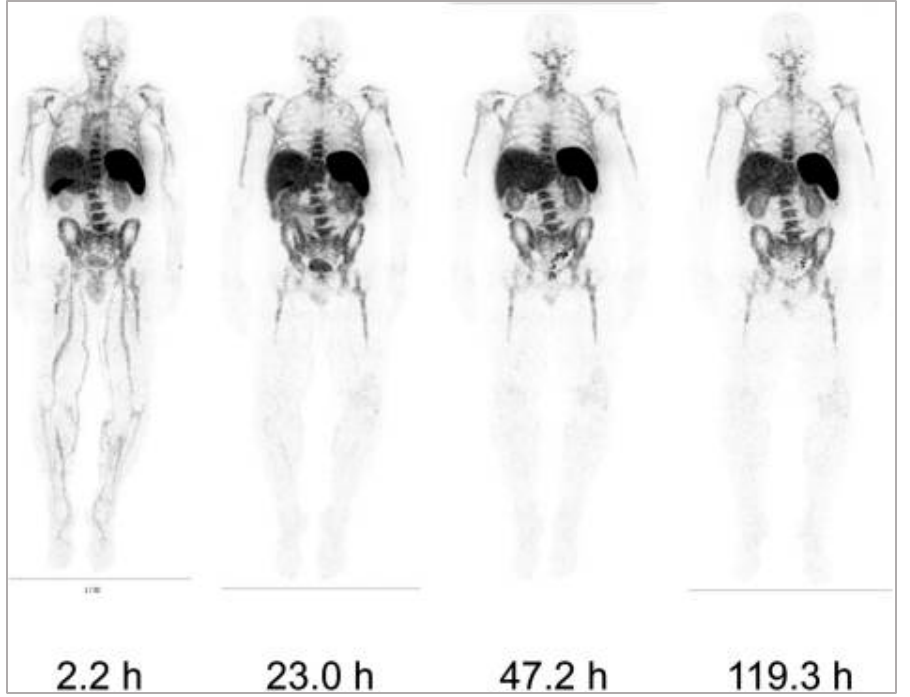
Figure 5. Whole-body images of a 1.5 mg minibody dose of [ 89 Zr]Zr-DFO-IAB22M2C at different time points post-injection in one patient. Reproduced from Pandit-Taskar et al. [133].